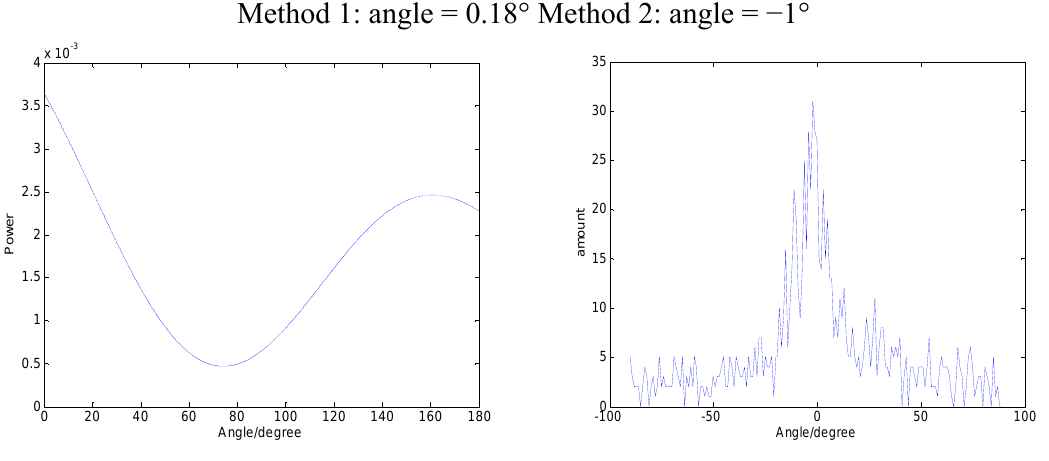
Figure 12. The results of the two methods